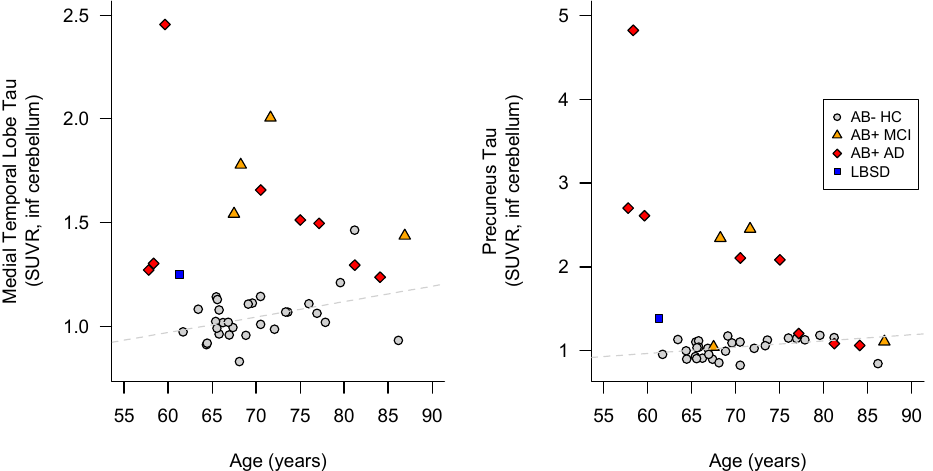
Figure 2. Age and tau PET scans, according to amyloid deposition positivity, in Stanford ADRC participants. Family 1: affected son of the index case is reported as a blue square (LBSD). AB = beta-amyloid; AD = Alzheimer’s disease; HC = healthy control; MCI = mild cognitive impairment.